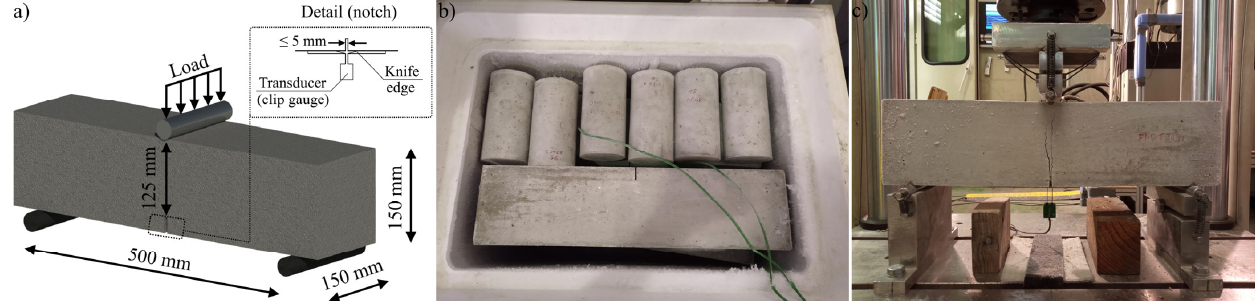
Figure 2. ( a ) 3PBT setup; ( b ) freezing procedure and temperature monitoring; ( c ) 3PBT at − 30